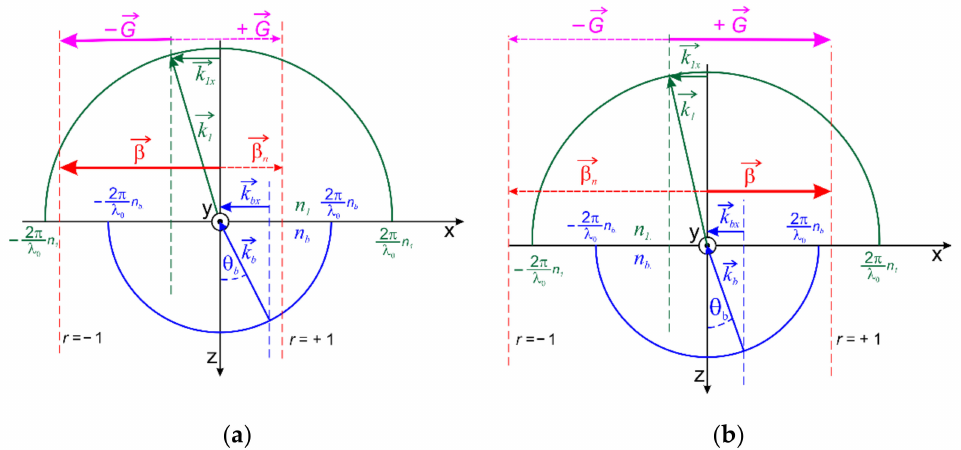
Figure 2. Wave-vector diagrams for coupling an incident light beam to a slab waveguide in the case of co-directional coupling ( a ) and counter-directional coupling ( b ) case, respectively.